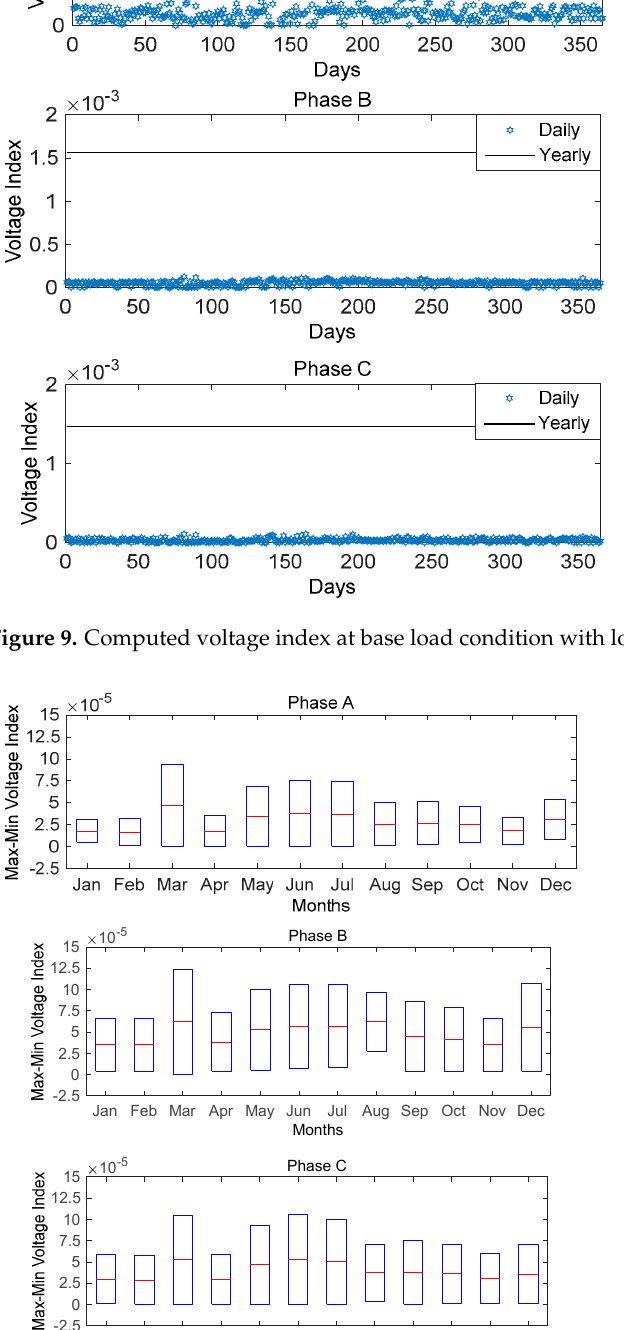
Figure 10. Maximum and minimum voltage index at the base load condition with a low solar radi- ation profile.